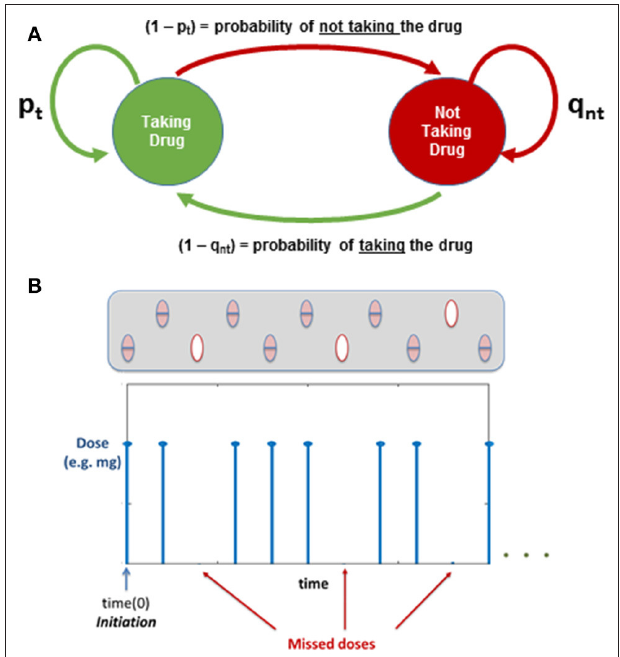
FIGURE 6 | (A) Markov Chain: Evaluating Medication Adherence; p t and q nt are probabilities based on the previous action ( i-1 ). (B) Illustration of how the dose regime is affected by the Markov Chain.